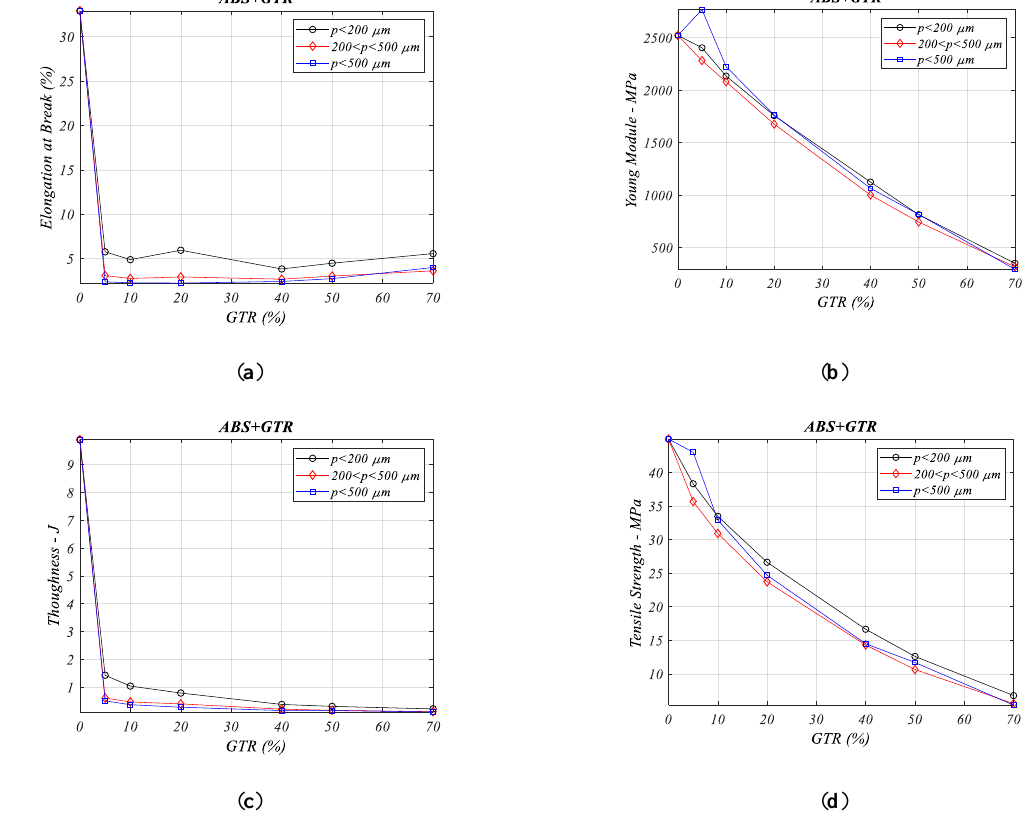
Figure 6. Mechanical properties analysis for different percentages of ABS/GTR composites and particle diameters: ( a ) elongation at break (%), ( b ) Young ’s modulus (MPa), ( c ) toughness (J) ( d ) tensile stress (MPa).